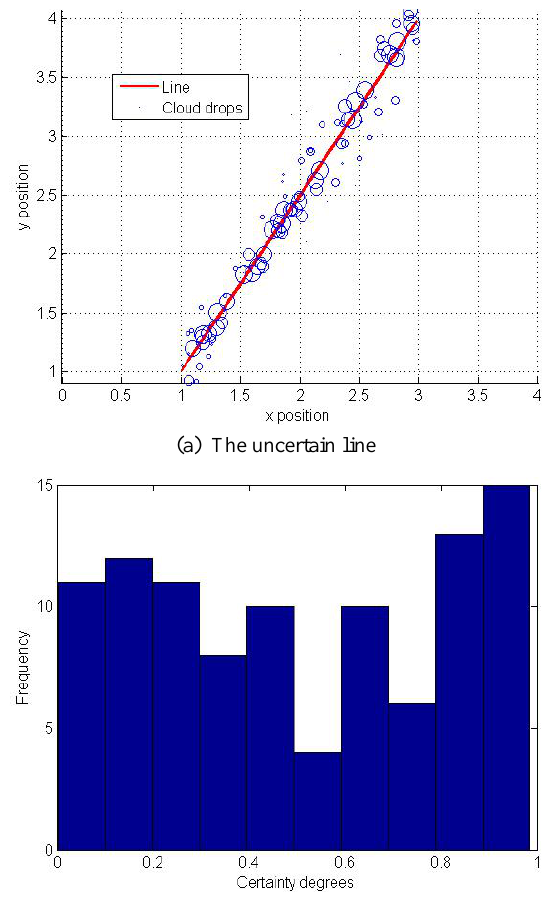
Figure 2. The uncertain line and its certainty degree The location relations between the sample points and the line are as shown in Figure 2(a). The circles with various sizes denote cloud drops of sample points, whose size is related with its certainty degree. As can be seen from Figure 2(a), these sample points are around the line segment with a nonuniform distribution. Intuitively, most of offset values between the